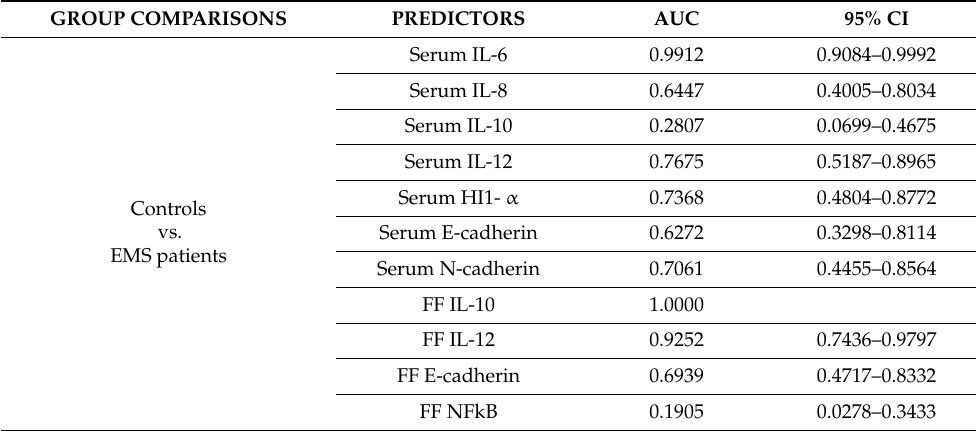
Table 4. Diagnostic accuracies of serum and FF biomarkers in differentiating control women from EMS patients. AUROC, area under the receiving operating characteristic curve; CI, confidence